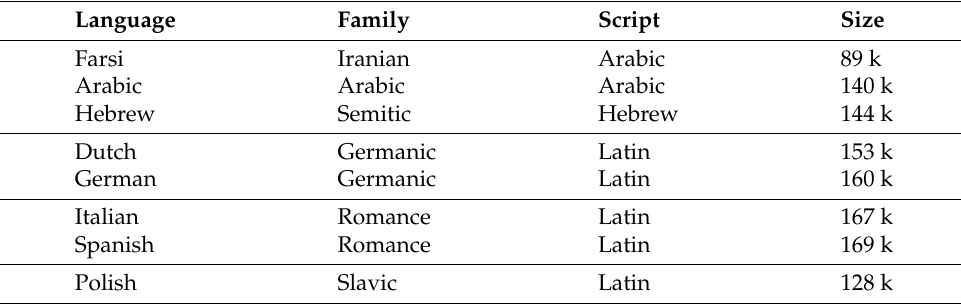
Table 2. Statistics of the IWSLT-8 dataset collected from